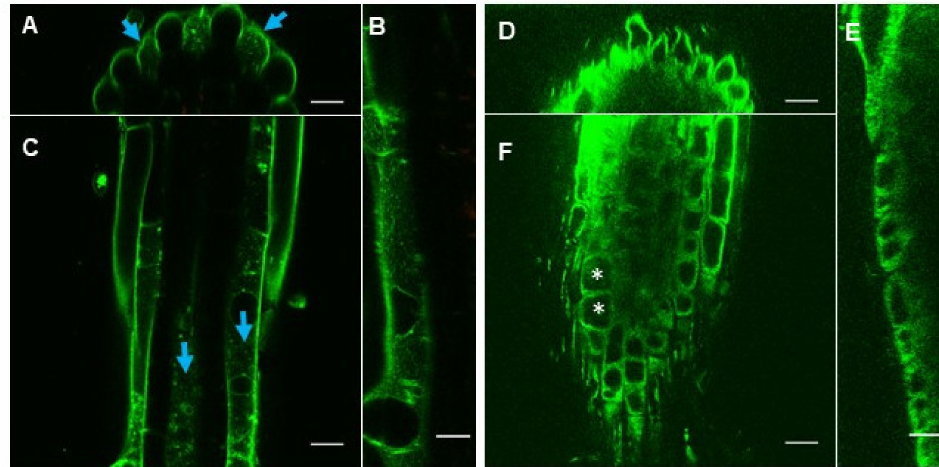
Figure 4. Representative images of differentiation zone ( A , B , C ) and meristem ( D , E , F ) of 5-day- old Arabidopsis thaliana Col-0 plants after 24 h of incubation on media containing 1 µ M eBL-BODIPY. Orthogonal cuts of XZ ( A , D ), YZ ( B , E ) and XY ( C , F ) planes; Z-stack of 149 slices, scale bar 20 µ m. Blue arrows indicate trichoblast cell lines; white asterisks indicate vacuolar